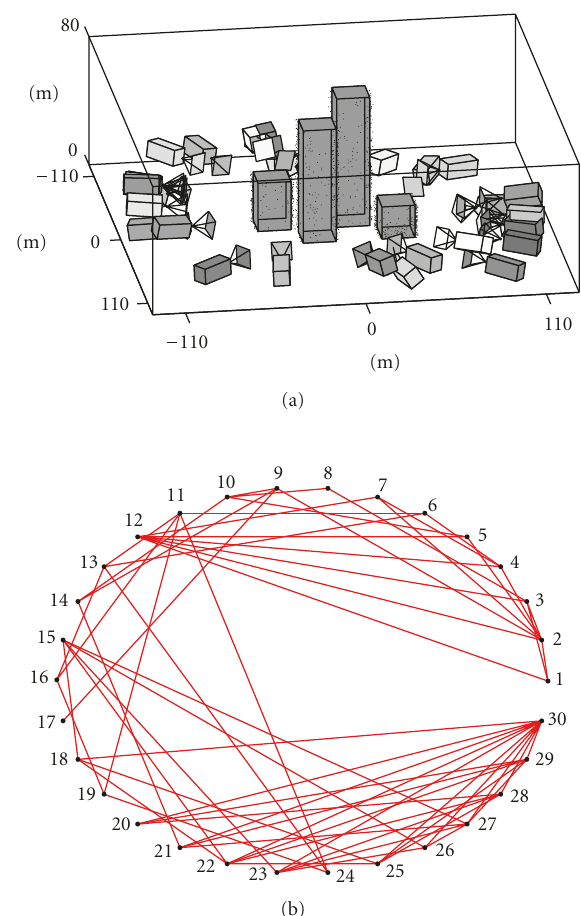
Figure 4: (a) The field of view of each of the simulated cameras. Focal lengths have been exaggerated, (b) the corresponding vision